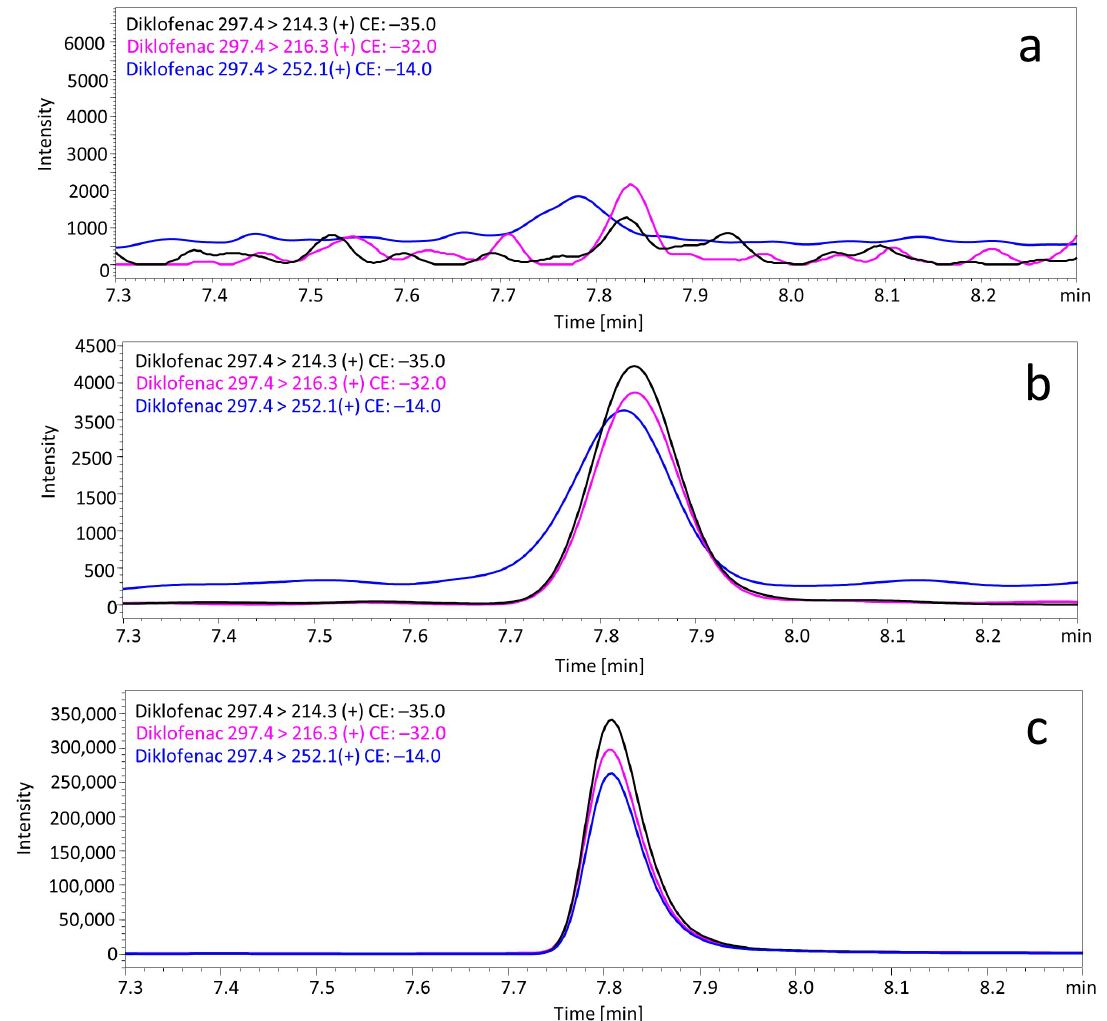
Figure 2. MRM (multiple reaction monitoring) chromatograms of diclofenac in ( a ) blank human postmortem blood, ( b ) low QC: 1 ng/mL, and ( c ) real sample of human blood (case